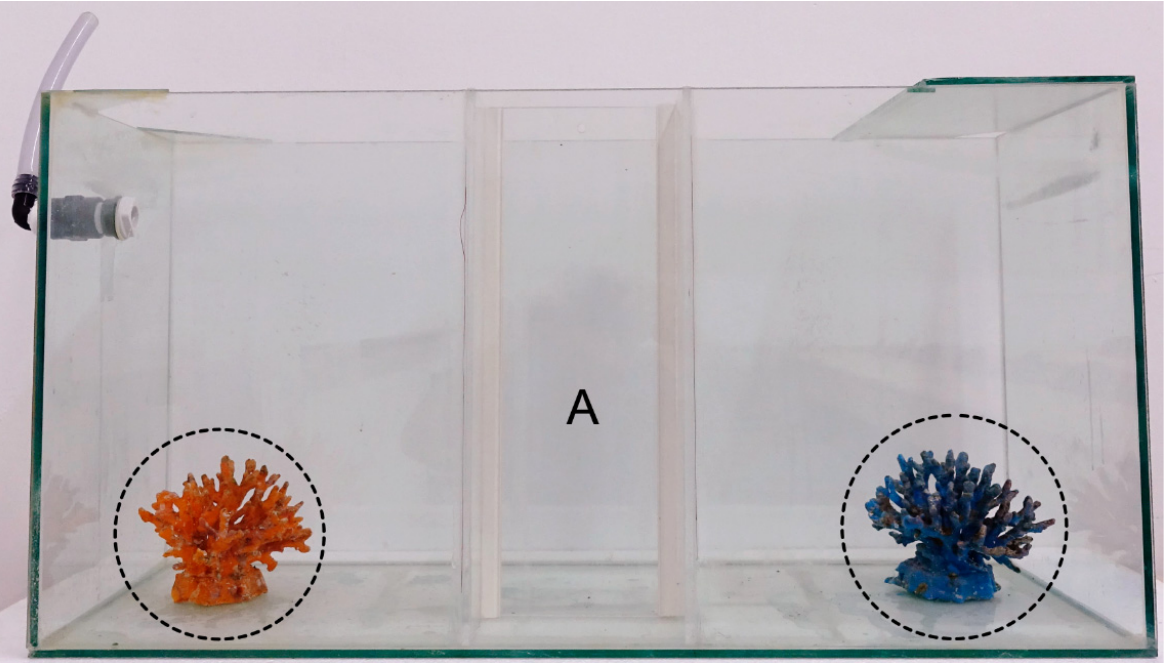
Figure 1. The experimental setup. A tank with a holding chamber ( A ) in its center. After acclimation, a gate was raised and the fish were allowed to choose between two shelters set on the far sides of the tank. Circles around the shelters illustrate the area in which fishes were